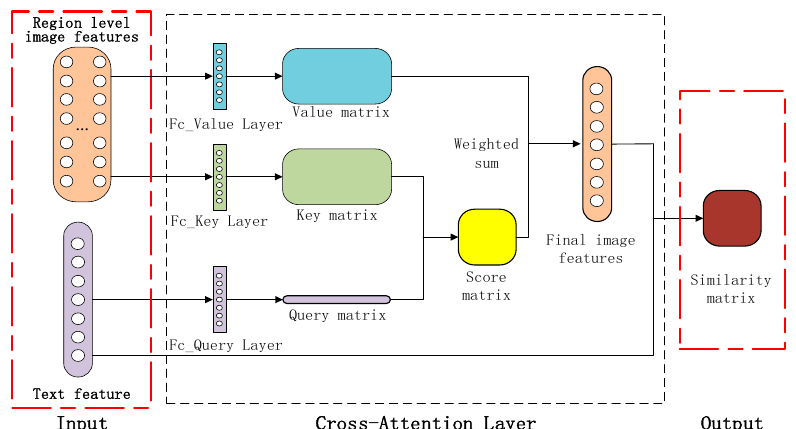
Figure 4. Detailed structural diagram of CAL. CAL is used for cross-modal information fusion, with three fully connected layers as its components. The inputs of the Fc_Value Layer and Fc_Key Layer are regional-level image features, and the outputs are a value matrix and a key matrix, respectively; the input of the Fc_Query Layer is text features, and the output is a query matrix. Finally, this layer will converge on the query matrix as a clue to get the final image feature representation and calculate the similarity score between it and texts. The output of the entire CAL is a similarity matrix of image-text pairs.